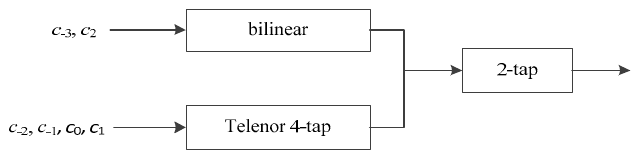
Figure 6. The process of directional interpolation. Table 1. The applied filters of the directional interpolation process.